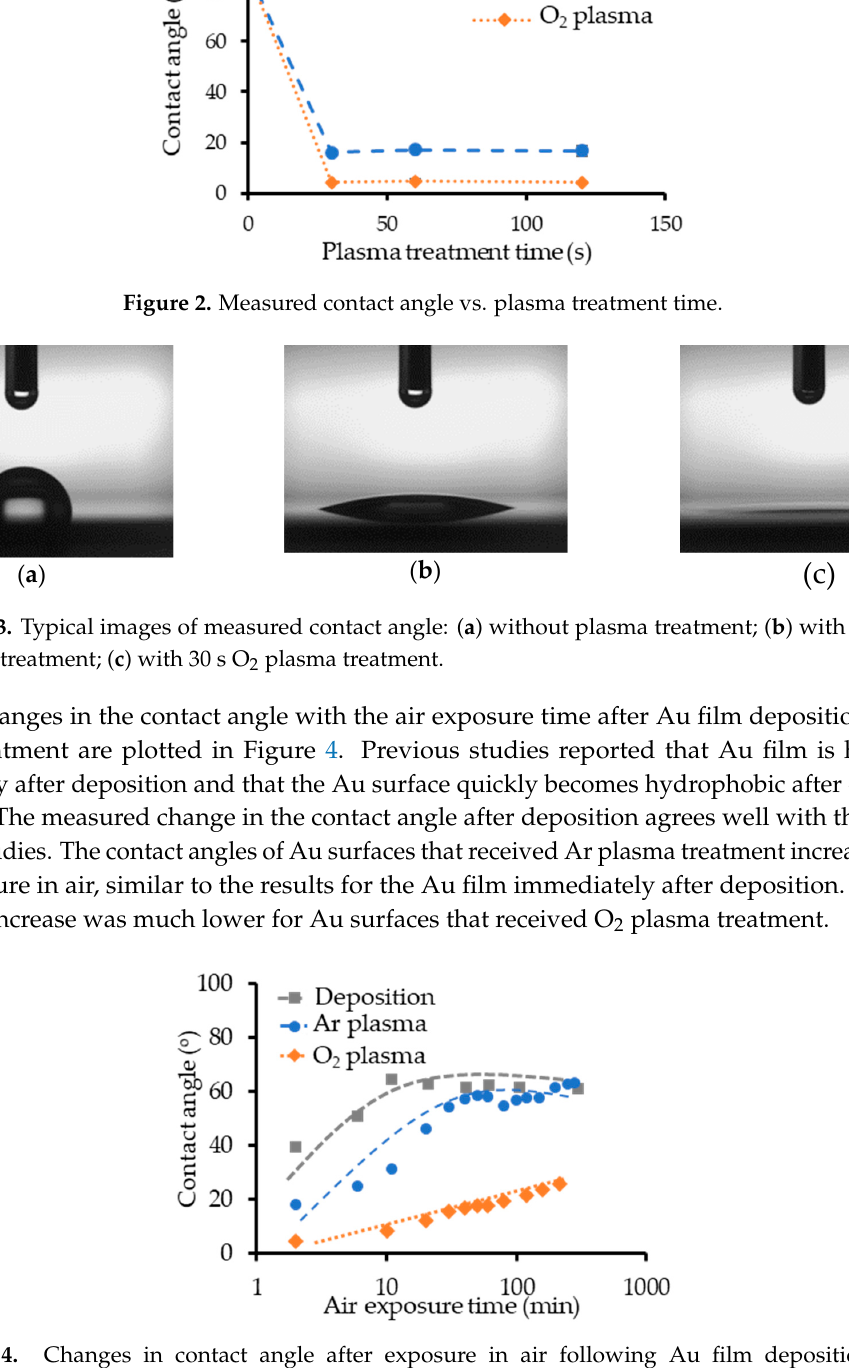
Figure 4. Changes in contact angle after exposure in air following Au film deposition and plasma